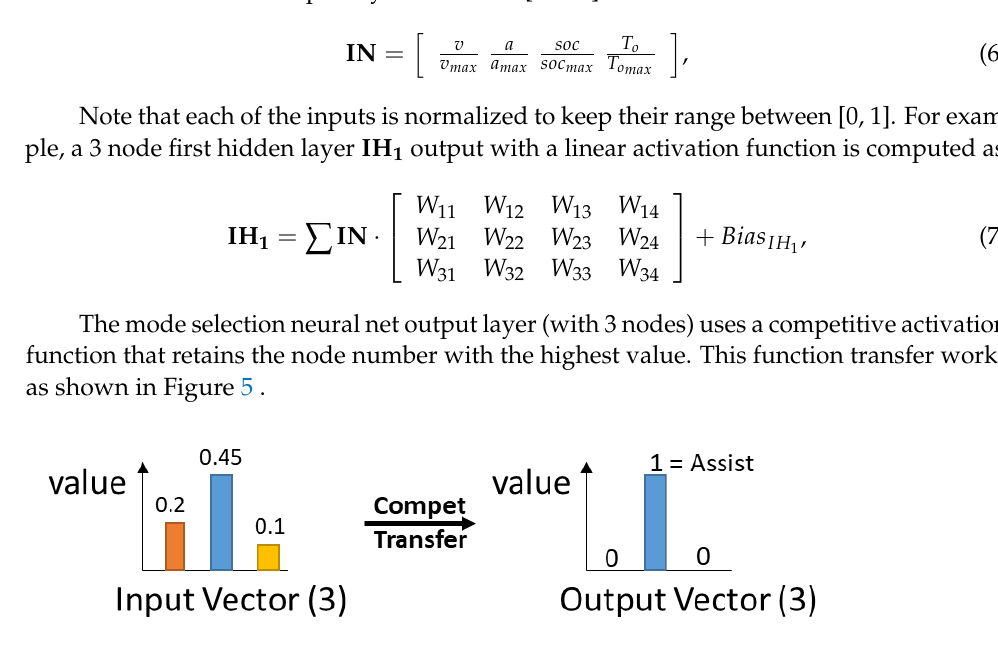
Figure 5. Competitive Transfer Function for mode switch